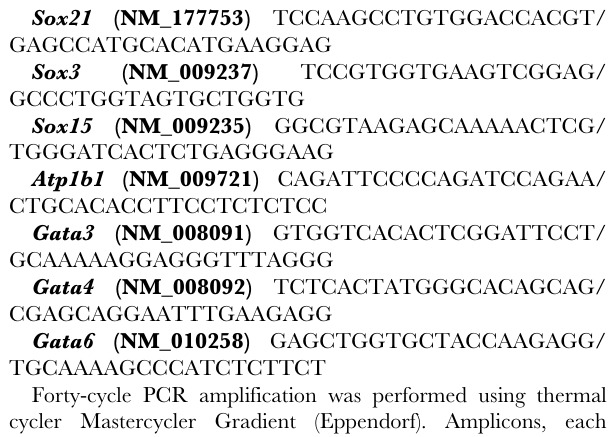
Figure S2 Development of MF1xMF1 embryos after RNAi. Sox2-duplex-1-siRNA embryos (hatched, N=30) were compared with incubator-control (grey, N=20), FFL-siRNA (black, N= 27) and bench-control embryos (white, N= 22). On day 5, while control embryos formed blastocysts from 80% to 92.6%, only 3.3% of the Sox2-siRNA embryos formed blastocysts, with 96.7% arresting at the morula stage. On day 5, chi-square tests revealed significant differences (p , 0.0001) between the % of Sox2-siRNA morulae and all control morulae, as well as between the % of Sox2-siRNA blastocysts and all control blastocysts. Found at: doi:10.1371/journal.pone.0013952.s002 (0.22 MB DOC) Figure S3 Immunostaining of day 4 and day 5 incubator ctrl (untreated) and Sox2-duplex-3-siRNA embryos, with different Sox2 (Chemicon) and Cdx2 (Biogenex) antibodies than the ones presented in Figure 4. This confirms the expression pattern described in Figures 3 and 4 for both markers, as well as absence of Sox2 and Cdx2 proteins after Sox2 RNAi. The images are single optical sections from confocal Z-series. At least 10 embryos were stained for each antigen and representative embryos (not Sox2 siRNA ‘escapees’) are shown. Bars: 50 m m. Figure S4 RT-PCR for Sox2, Fgfr2, Fgf4, Cdx2, Eomes, Tead4, Oct4, Nanog, Sox1, Sox3, Sox14, Sox15, Sox21 and Beta-actin (40 cycles) on day 4: incubator-control embryos (lanes 1 and 3); Sox2-duplex-1-siRNA embryos (lane 2); Sox2-duplex-3-siRNA embryos (lane 4). In the absence of Sox2 transcripts after siRNA, a clear reduction of Fgfr2, Ffg4, Cdx2, Eomes and Tead4 transcripts in Sox2-siRNA embryos was observed. Oct4 and Nanog transcripts were unaffected in Sox2 knock-down morulae com- pared to incubator-control morulae. Sox1, Sox3, Sox14, Sox15 and Sox21 transcripts were not expressed in any of the control or Sox2 knock-down morulae. Beta actin transcripts were detected in all embryos. Figure S5 Immunofluorescence confirmation of transferred Sox2 after initiation of the rescue experiment using the Sox2- TAT protein. Sox2 siRNA R embryos were immunostained with Sox2 6h, 12h and 18h after the first addition of Sox2-TAT protein, to assess Sox2 protein recovery efficiency. Gradual expression of Sox2 protein was confirmed, with signs of possible endocytic uptake of the protein, as indicated by patchy expression of Sox2. Figure S6 Immunological controls of embryo staining presented in Figures 3 and 4; the upper panel (A to K) shows controls for dual staining, the lower panel (L to S) illustrates controls for staining with single antibodies. The images are single optical sections from confocal Z-series. In all cases, the controls were negative. A: anti-Sox2 1o + goat anti-mouse IgG (2o to Oct4, Cdx2Biogenex, Fgfr2, ZO1, Desmoplakin); B: anti-Oct4 1o + goat anti-rabbit IgG (2o to Sox2); C: anti-Cdx2Biogenex 1o + goat anti- rabbit IgG (2o to Sox2); D: anti-Fgfr2 1o + goat anti-rabbit IgG (2o to Sox2); E: anti-ZO1 1o + goat anti-rabbit IgG (2o to Sox2); F: anti-Desmoplakin 1o + goat anti-rabbit IgG (2o to Sox2); G: anti-Sox2 1o + donkey anti-goat IgG (2o to Nanog and Fgf4); H: anti-Nanog 1o + donkey anti-rabbit IgG (2o to Sox2); I: anti-Fgf4 1o + donkey anti-rabbit IgG (2o to Sox2); J: anti-E-cadherin 1o + goat anti-rabbit IgG (2o to Sox2); K: anti-Sox2 1o + goat anti-rat IgG (2o to E-cadherin); L: Rabbit IgG isotype control to Sox2, Cdx2Jane Collins, Eomes, Occludin 1o antibodies; M: Mouse IgG isotype control to Oct4, Cdx2Biogenex, Fgfr2, ZO1, Desmoplakin 1o antibodies; N: Goat IgG isotype control to Nanog, Fgf4 1o